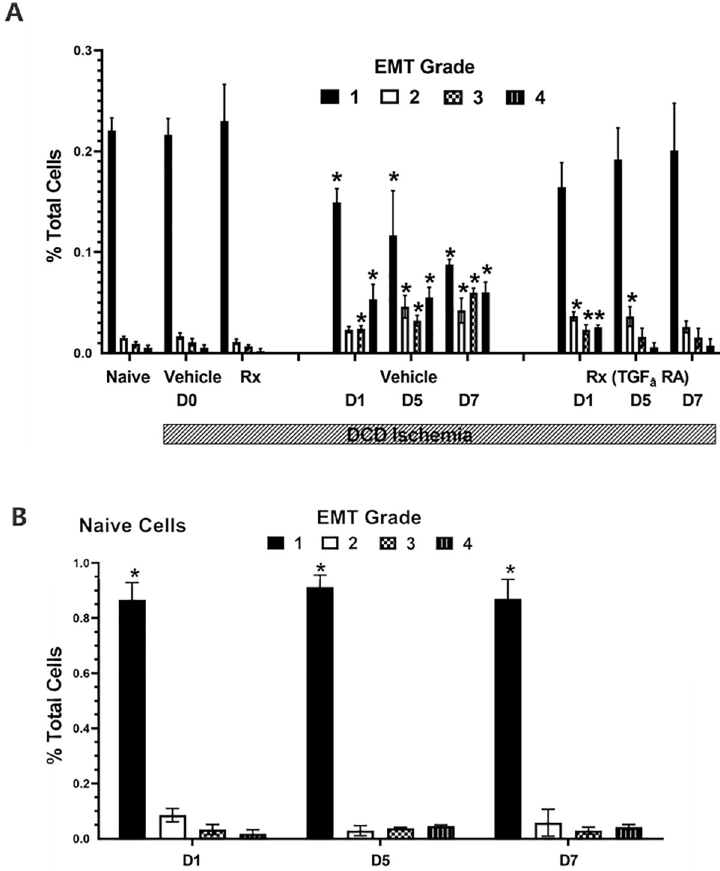
Fig 7. TGF β signaling and cholangiocyte morphology changes. Cell morphology results from the grading of images taken with light microscopy. Data are the mean percent of cells out of total cells. There are three main groups, the fresh Naive cholangiocytes (Naive), vehicle DMSO control cholangiocytes, and cholangiocytes pretreated with the selective TGF β receptor-1 antagonist Galunisertib (1 μ M, 1 hour before DCD ischemia). Cells were examined for morphometric changes immediately after induction of DCD ischemia (D0), 1 day after (D1), 5 days after (D5), or 7 days after (D7). The bar indicates the groups exposed to DCD ischemic conditions of 1 hour of warm ischemia and 24 hours of cold storage followed by the indicated time in days of return to normoxia and 37C temperatures. G1 refers to normal cuboidal appearance, GII to mostly cuboidal appearance, GIII refers to mostly spindle appearance, and GIV refers to spindle appearance. All images were graded in a blinded manner. � P < 0.05 relative to the corresponding bar in the control or treated (Rx) groups at D0. N =